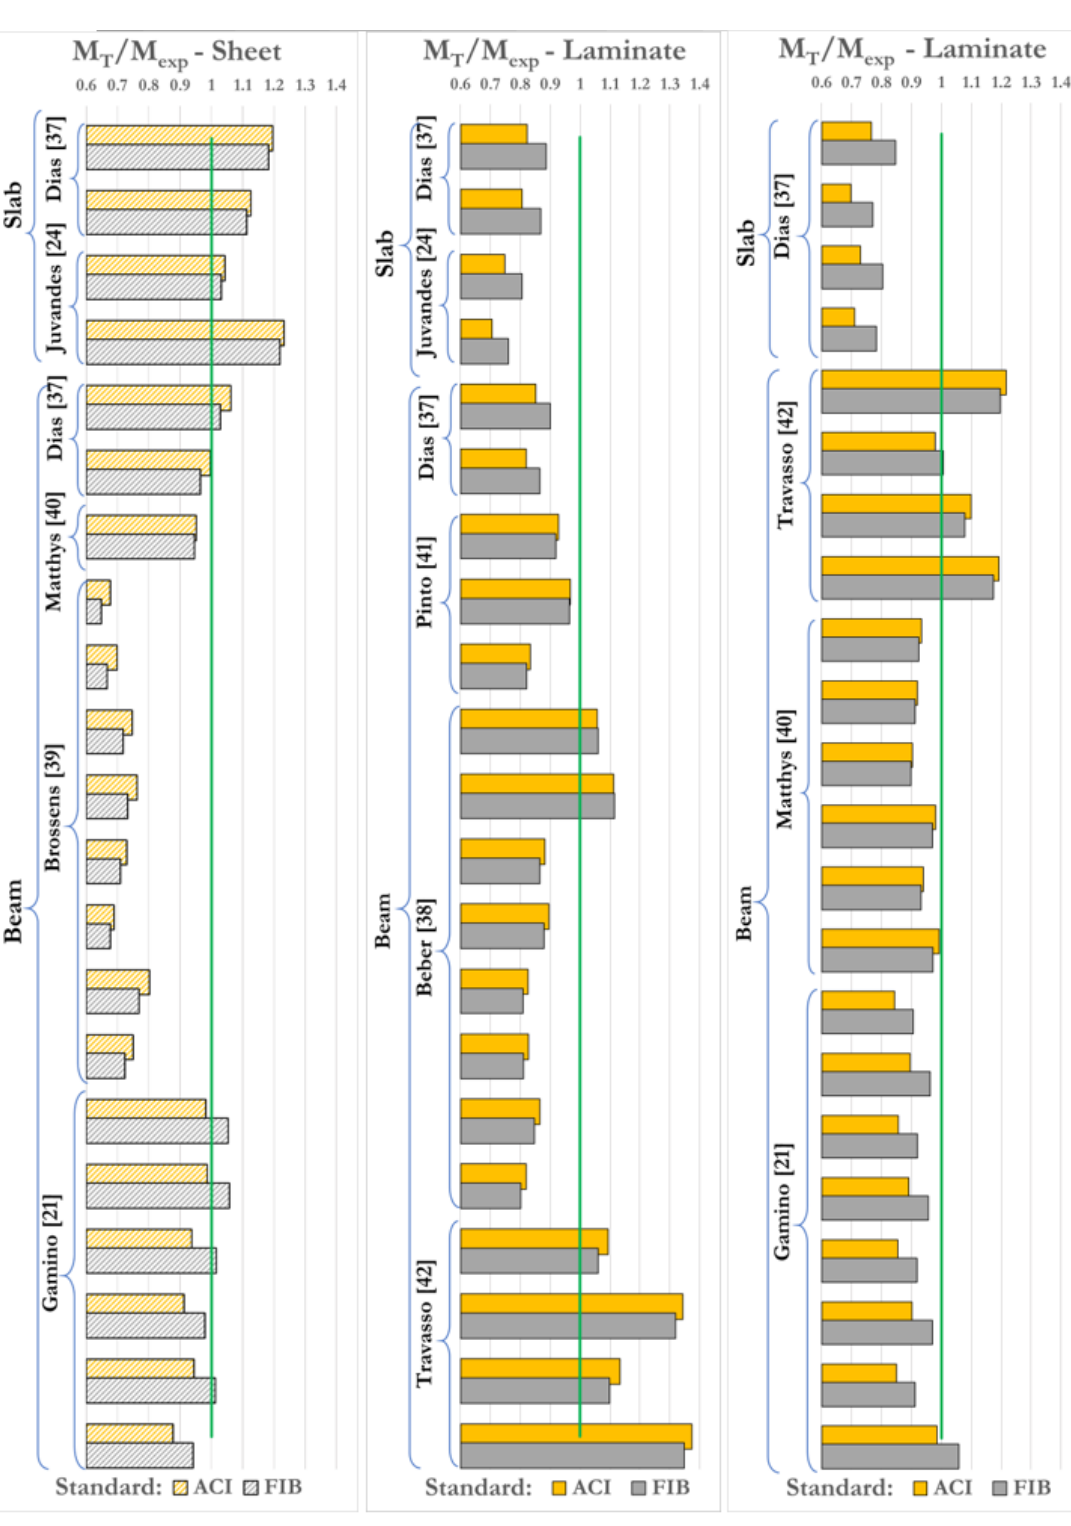
Figure 4. ACI440 x FIB - Analysis of the ultimate moment of the 64 experimental data ( theoretical M / exp M